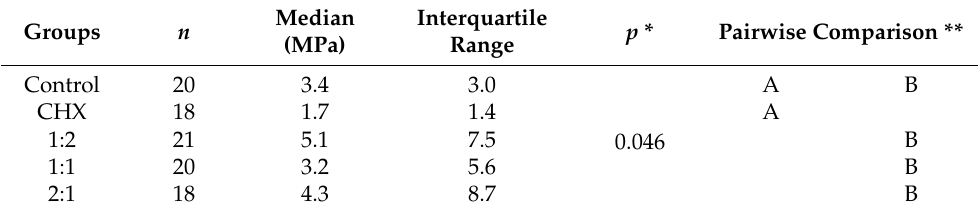
Table 1. Results of the Kruskal Wallis H test for shear bond strength.